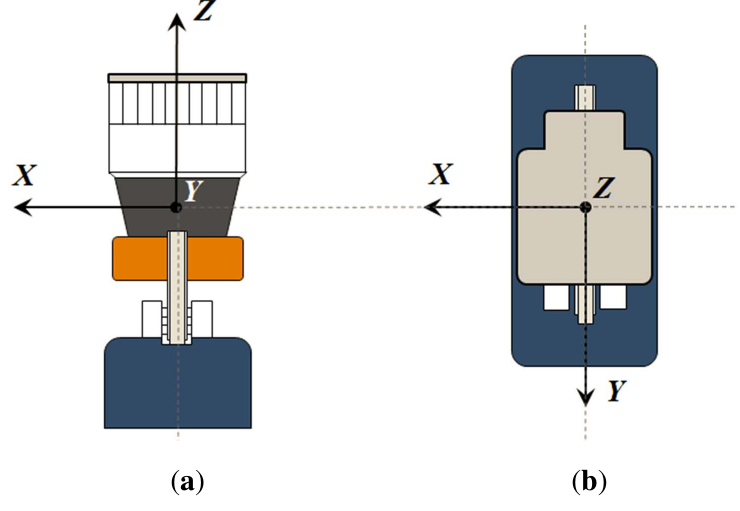
Figure 6. UNOlaser reference frame: front ( a ) and top ( b )